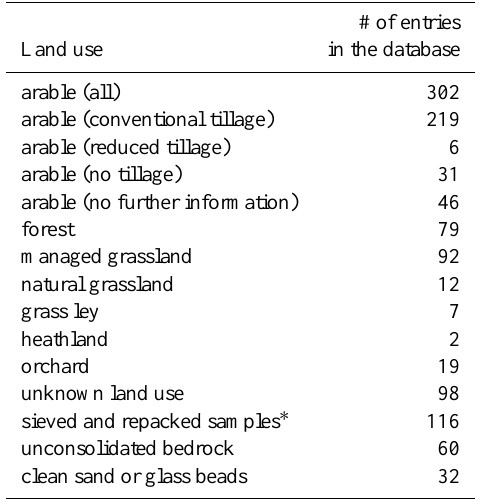
Table 3. Land use and soil management for the 733 datasets in the database.